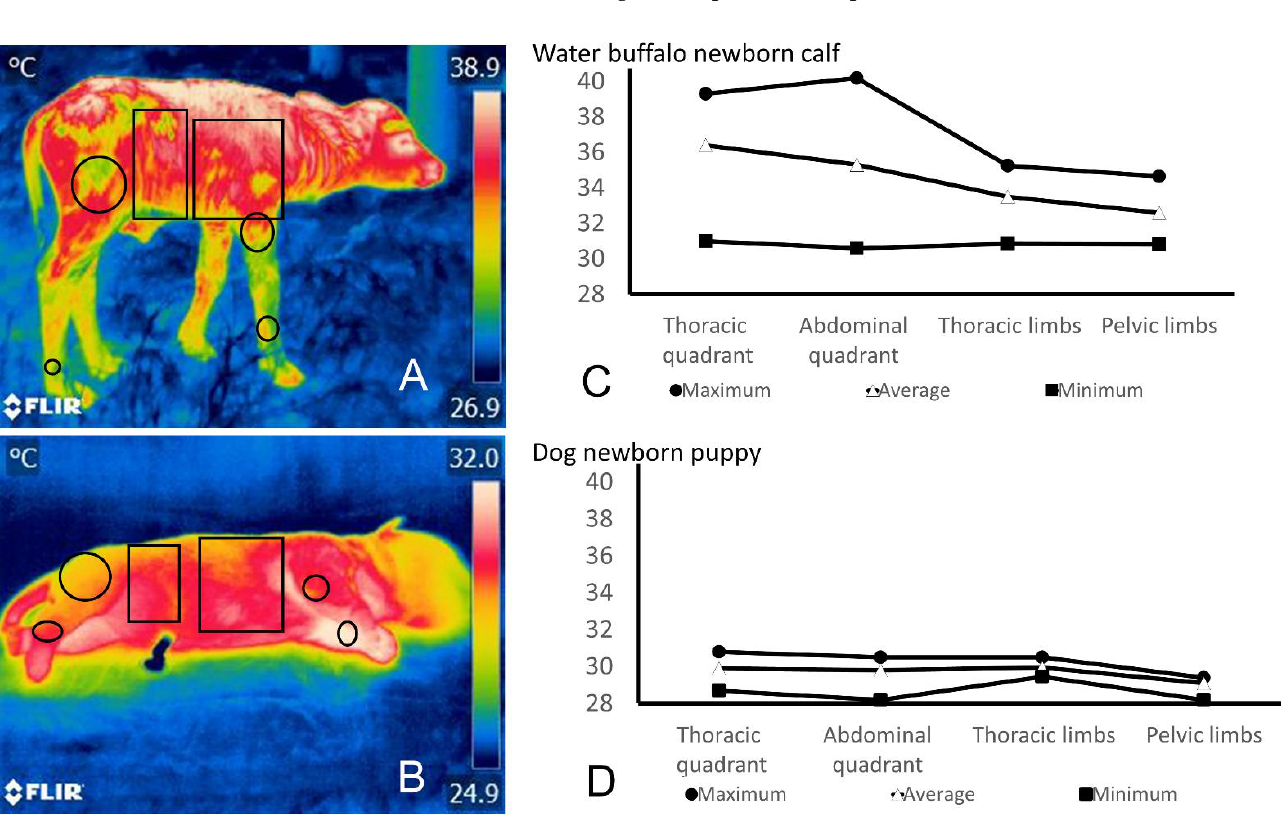
Figure 4. Thermographic evaluation in altricial and precocial neonates. ( A ) Dry newborn water buffalo calf ( Bubalus bubalis ) thermogram. The maximum temperature (shown as a white color in the thermogram) is observed in the facial and thoracic region, while the coolest temperatures (color green and yellow) are observed in the forelimbs and hindlimbs. ( B ) Dry newborn puppy ( Canis lupus familiaris ) thermogram. The maximum temperature can be seen in the cranial region of the thoracic and pelvic limbs (white color), while the back and the facial region (yellow color) and the nose (green color) of the newborn represent the coolest regions. ( C ) The graph exhibits the maximum, minimum, and average temperatures of the water buffalo newborn calf’s thoracic, abdominal, forelimb, and hindlimb areas. ( D ) The graph displays the newborn puppy’s maximum, minimum, and average temperature in the thoracic, abdominal, forelimbs, and hindlimb areas. A significant difference between the temperatures of both species can be recognized, where the water buffalo newborn calf has the highest values regardless of the evaluated region. Both thermograms were recorded at minute 60 post-birth to compare the thermoregulatory ability of a precocial animal (water buffalo neborn calf) and an altricial animal (puppy dog). The authors took the thermographic images with a FLIR E80 camera with an 18 mm FOL lens at a resolution of 320 × 240 pixels and the ability to accurately measure temperatures from − 20 ◦ C to 550 ◦ C/ − 4 ◦ F to 1022 ◦ F (emissivity = 0.95, distance = 30